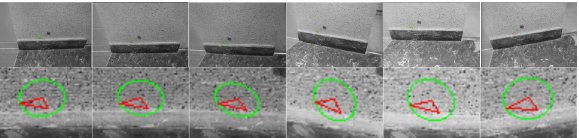
Figure 3. Different ellipses given by different directions of observation. The image on the right is selected as the master image for the concerned 3D triangle.